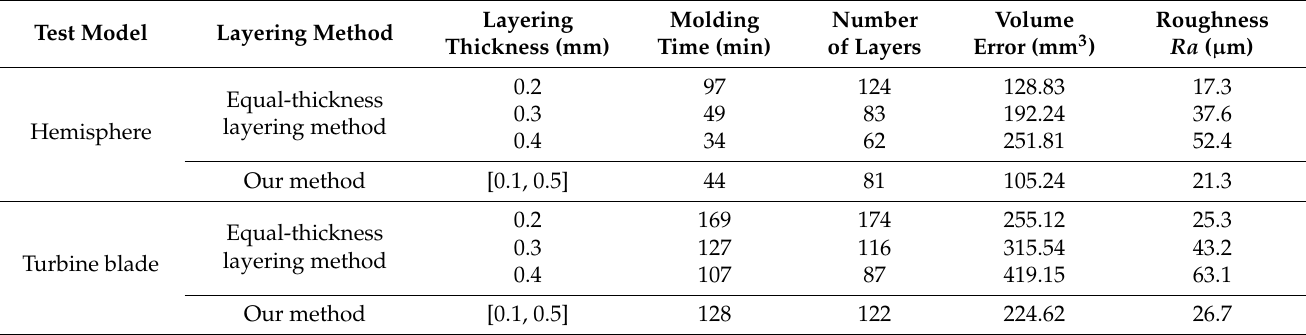
Table 1. Experimental measurement